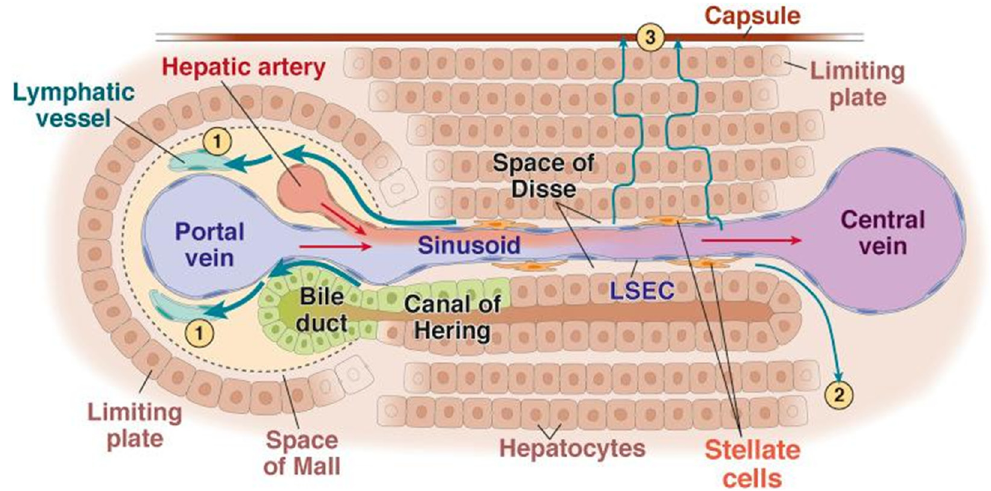
Figure 4. Schematic representation of the intra lobule vascularization to the central vein from one of the six triads. 1,2,3: lymphatic fluid flows. (reprinted from [39] with permission of